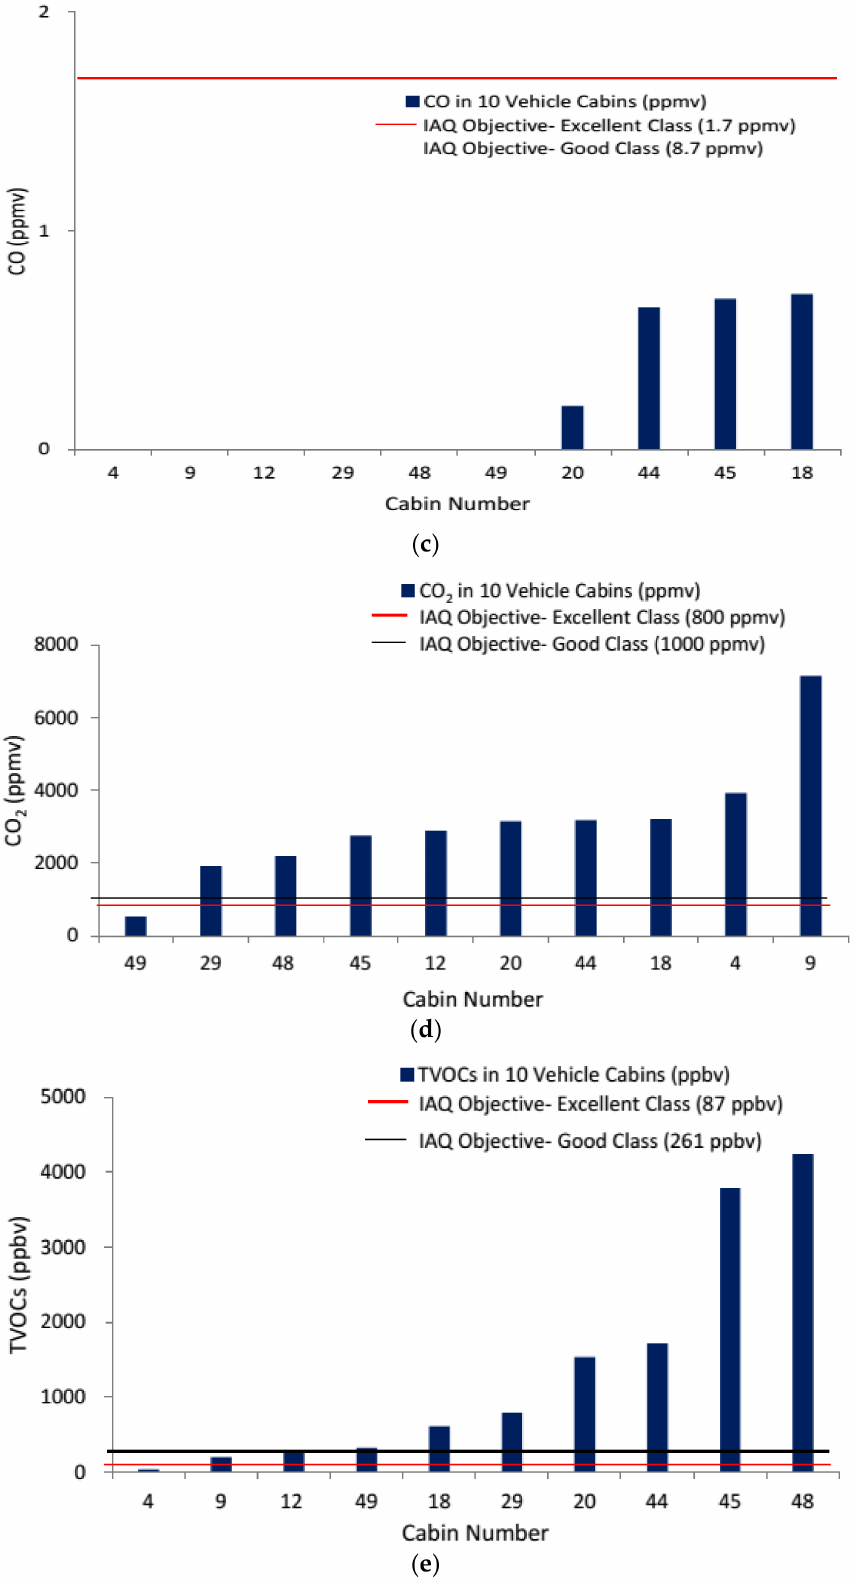
Figure 2. The IAQ parameters in the in-cabin microenvironment during engine idling, PM 2.5 ( a ); PM 0.3 ( b ); CO ( c ); CO 2 ( d ); and, TVOCs ( e ). As there are no IAQ guidelines for PM 0.3 and PM 2.5 , the PM 2.5 levels were compared with the levels recorded in different districts in Hong